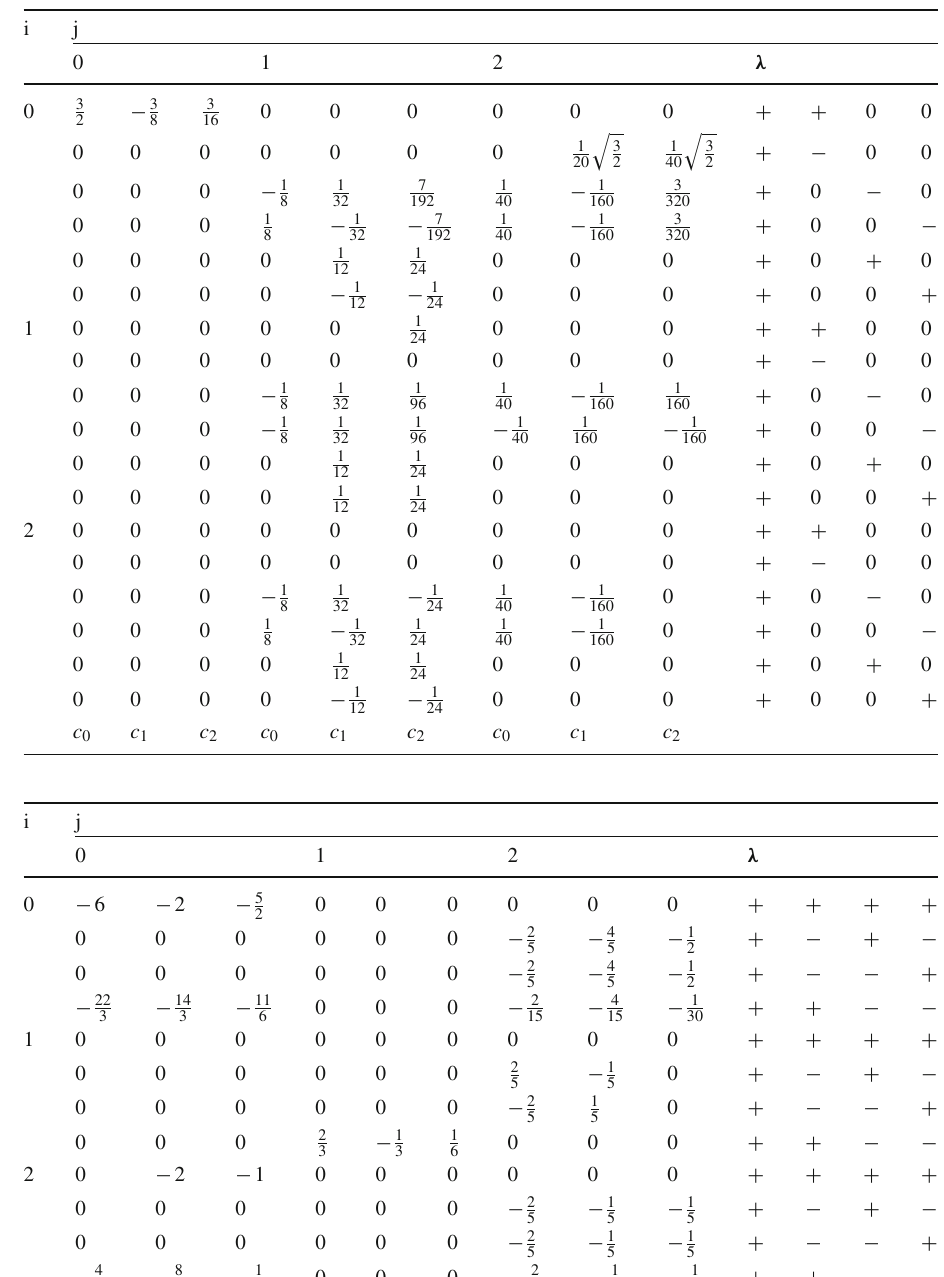
isospin-spin amplitudes calculated with Eq. (14) for the mixed operators L M on the helicity of the incoming and outgoing particles. The isospin spin amplitudes are given by A ij ( s ; λ ) = ( c